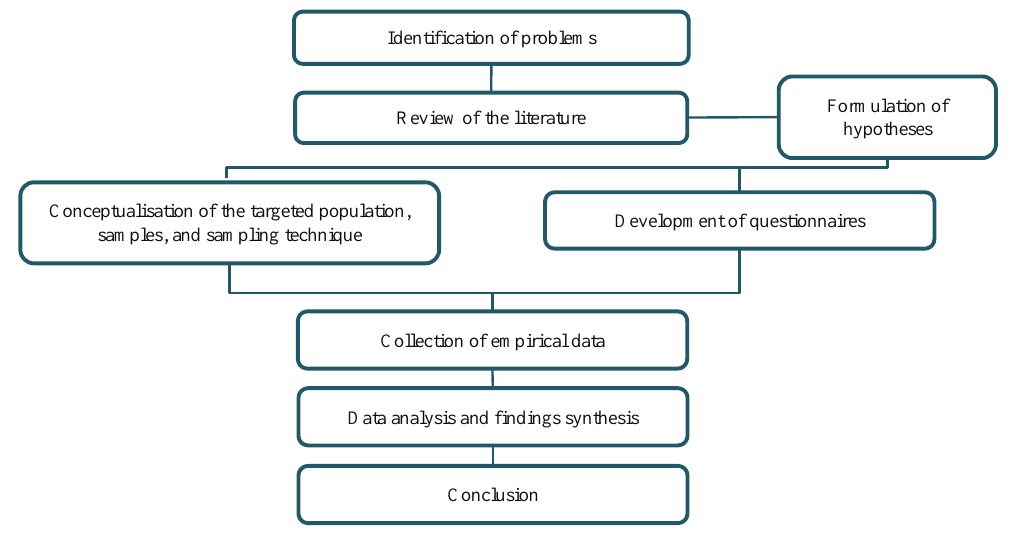
Figure 3. Flowchart of the Research Methodology